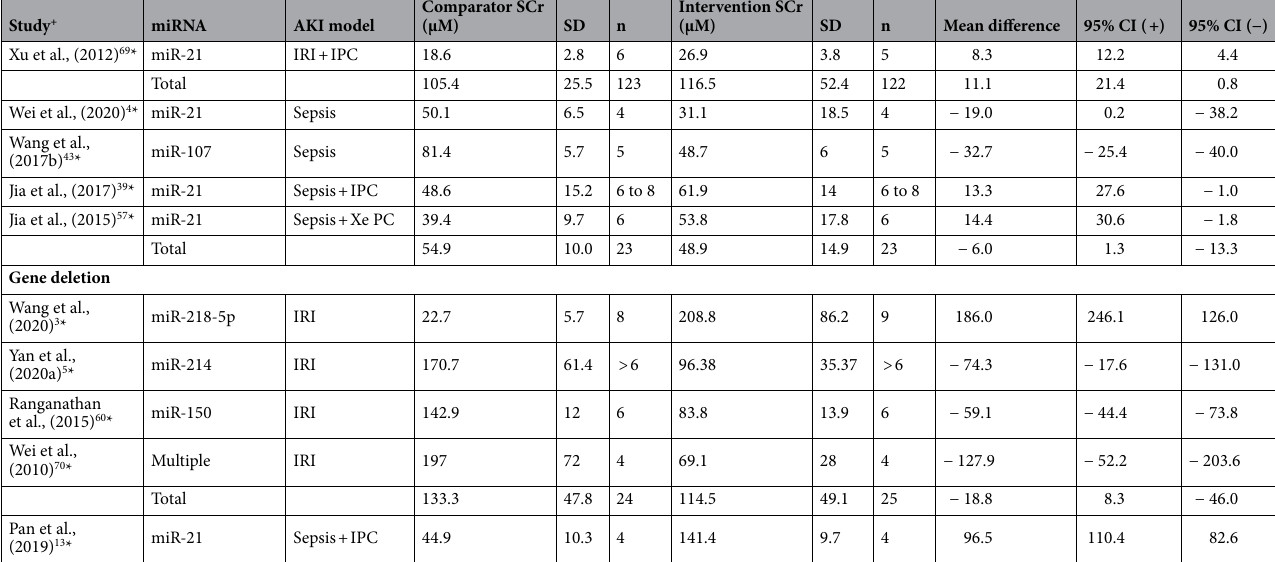
Table 1. Effect of intervention and model on serum creatinine in mice with AKI. AKI acute kidney injury, CI confidence interval, CoCl 2 PC cobalt chloride preconditioning, IPC ischemic preconditioning, IRI ischemia reperfusion injury, LPS PC lipopolysaccharide preconditioning, miRNA micro-RNA, n sample size, NS